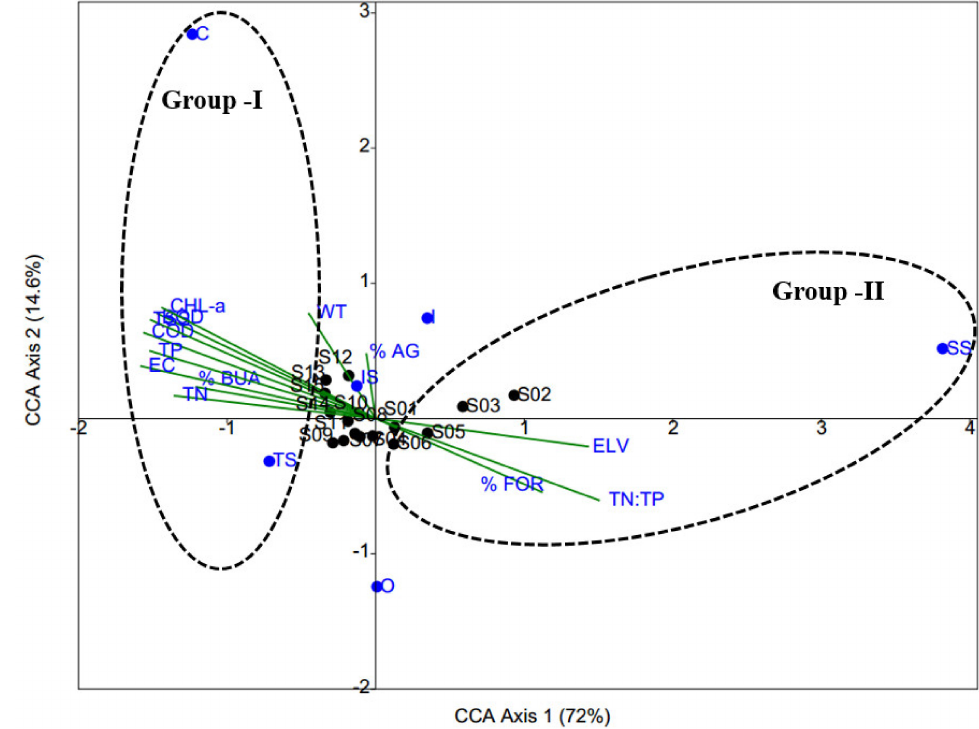
Figure 7. Canonical correspondence analysis (CCA) ordination diagram of trophic and tolerance guilds with water quality variables and land-use pattern and elevation. IS, intermediate species; SS, sensitive species; TS, tolerant species; C, carnivore; I, Insectivores; O, omnivores; AG, agricultural land-use coverage; FOR, forest land-use coverage; BUA, built-up area; WT, water temperature; BOD, biological oxygen demand; COD, chemical oxygen demand; TSS, total suspended solids; TP, total phosphorus; TN, total nitrogen; CHL-a, chlorophyll-a; EC, electrical